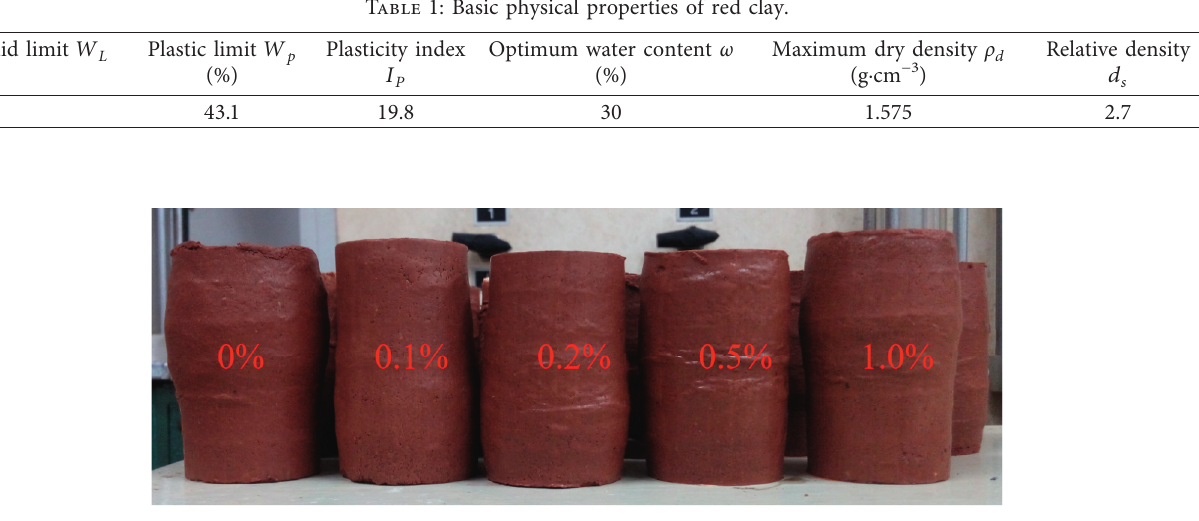
Figure 2: Failure state of red clay samples under different zinc ion concentrations. Table 2: Shear strength and shear strength